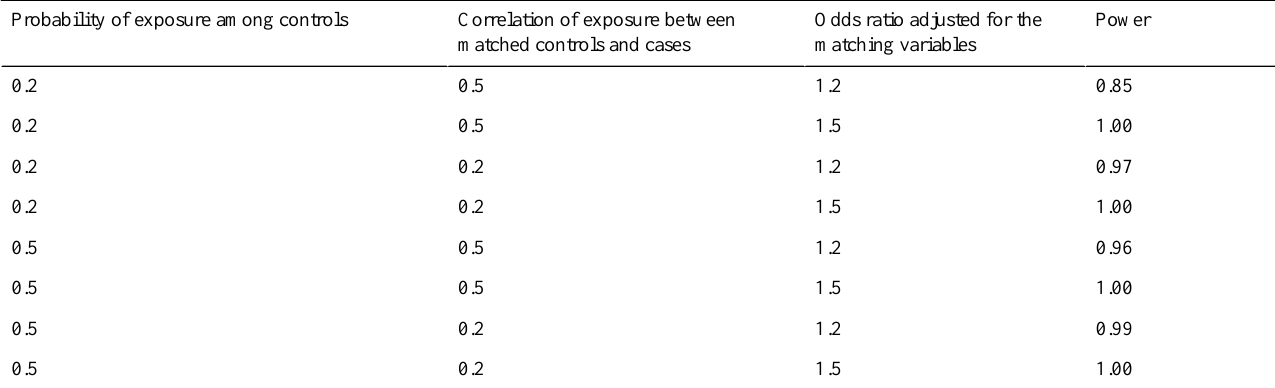
Table 2. Statistical power and sample size